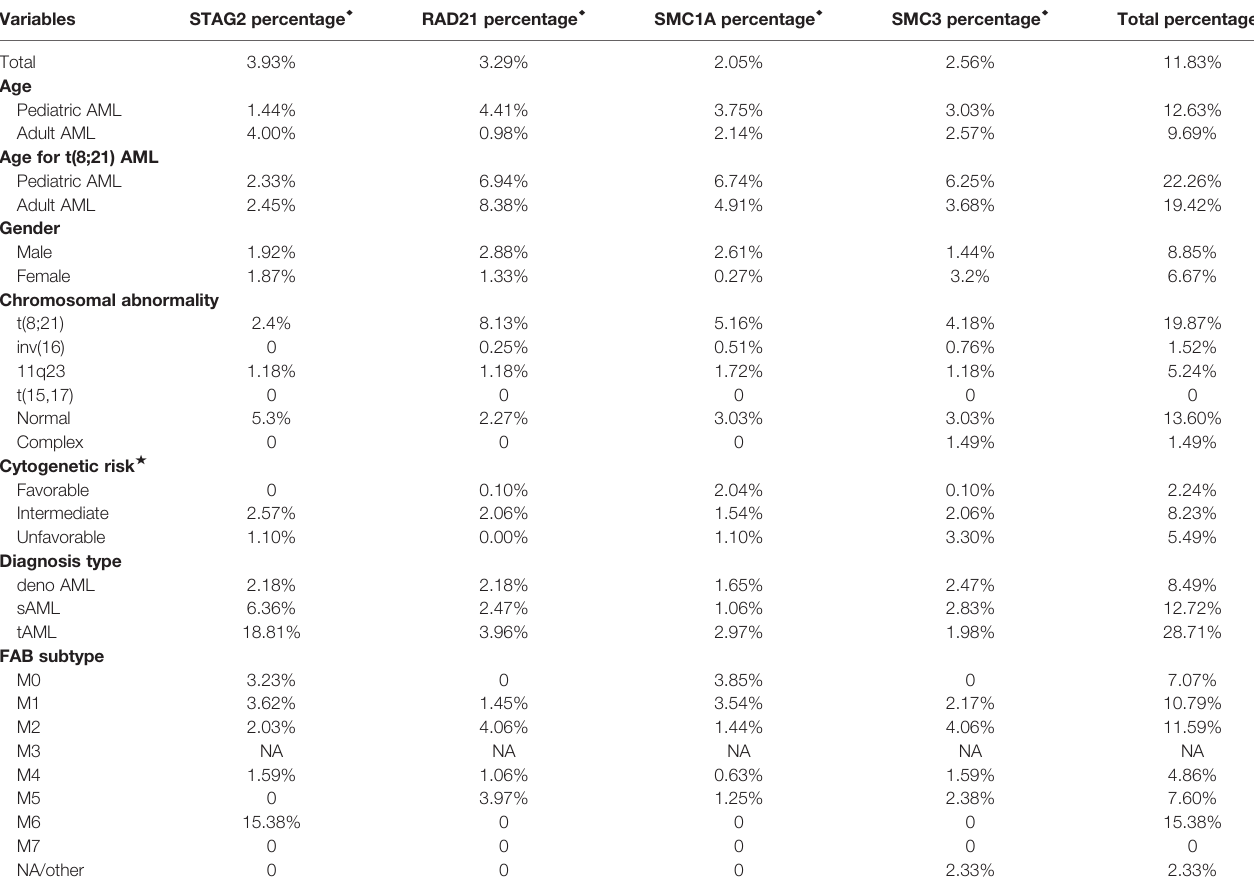
TABLE 1 | Characteristics of AML patients with cohesin mutation.